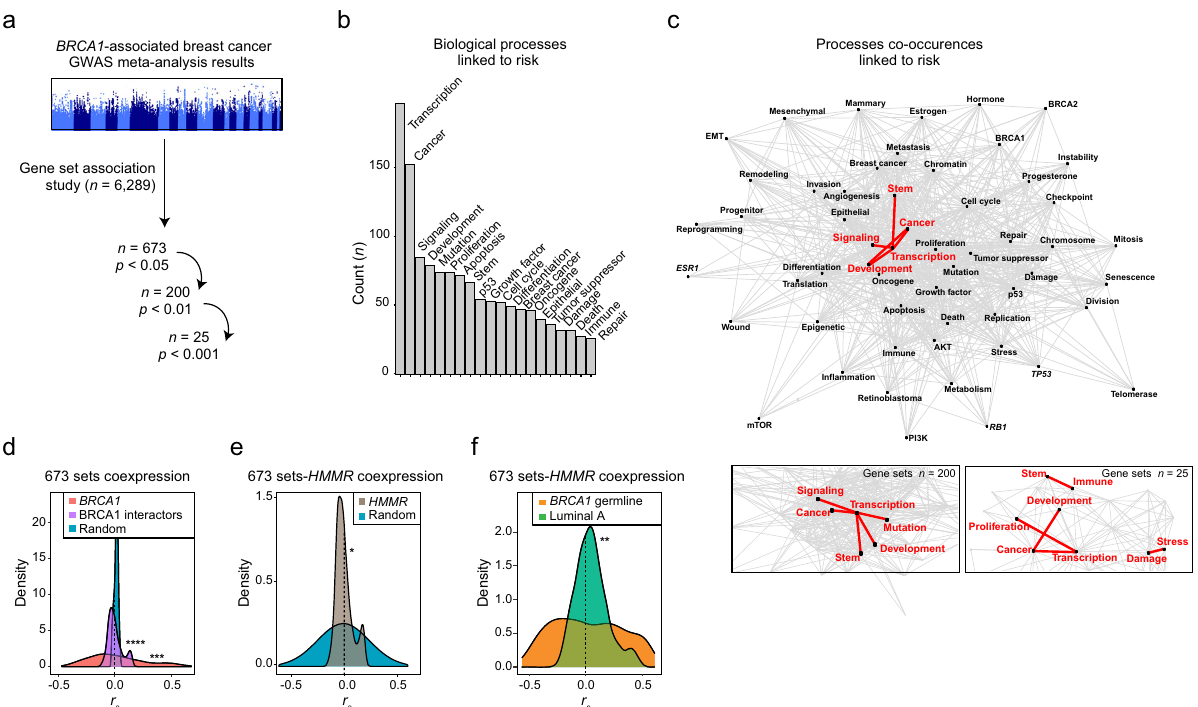
Fig. 1 Curated gene sets linked to BRCA1 -associated breast cancer risk and expression correlation with candidate modi fi er HMMR . a Gene set-based analysis of the summary statistics of the BRCA1 -associated and triple-negative breast cancer GWASs. The number of gene sets analyzed and of those found to be signi fi cantly associated at three scoring thresholds are indicated. b Biological annotation of 673 risk-linked gene sets using text mining. The 20 most frequently identi fi ed keywords in the corresponding publication abstracts are shown ( n , counts). c Top panel, network of the keywords mined across published studies of the 673 risk-linked gene sets. Centrality is proportional to the number of instances found, and edge length is inversely proportional to the number of times that two given keywords appear in a given abstract. Red edges and keywords depict the fi ve most frequent keyword pairs. Bottom panels, zoom-in into the most frequent pairs considering the subsets of 200 and 25 risk-linked gene sets. d Distributions of the coexpression coef fi cients (Spearman ’ s correlation coef fi cient, r s ) between the 673 sets and BRCA1 , genes coding for BRCA1 interactors, or equivalent randomly chosen genes (x1000), across TCGA primary breast tumors. The asterisks indicate signi fi cant difference relative to random (Wilcoxon test; *** p = 0.001 and **** p < 0.0001). e Distribution of coexpression coef fi cients ( r s ) between the 673 risk-linked gene sets and HMMR , and equivalent null distribution across TCGA primary breast tumors. The asterisk indicates signi fi cant difference: two-tailed Student ’ s paired-samples t test; * p = 0.010; HMMR 95% con fi dence interval (CI) 0.007 – 0.055; 671 degrees of freedom. f Distributions of coexpression coef fi cients ( r s ) between HMMR and the 673 risk-linked gene sets across primary tumors with germline BRCA1 pathological variants ( n = 18; indicated “ BRCA1 germline ” ) or luminal A tumors ( n = 234). The asterisks indicate signi fi cant difference (Wilcoxon test; ** p = chose to use the β -lactoglobulin promoter- Cre ( Blg-Cre ) trans-